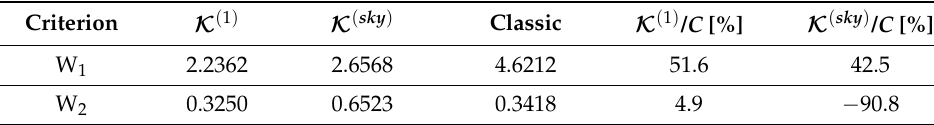
Table 1. Indicator